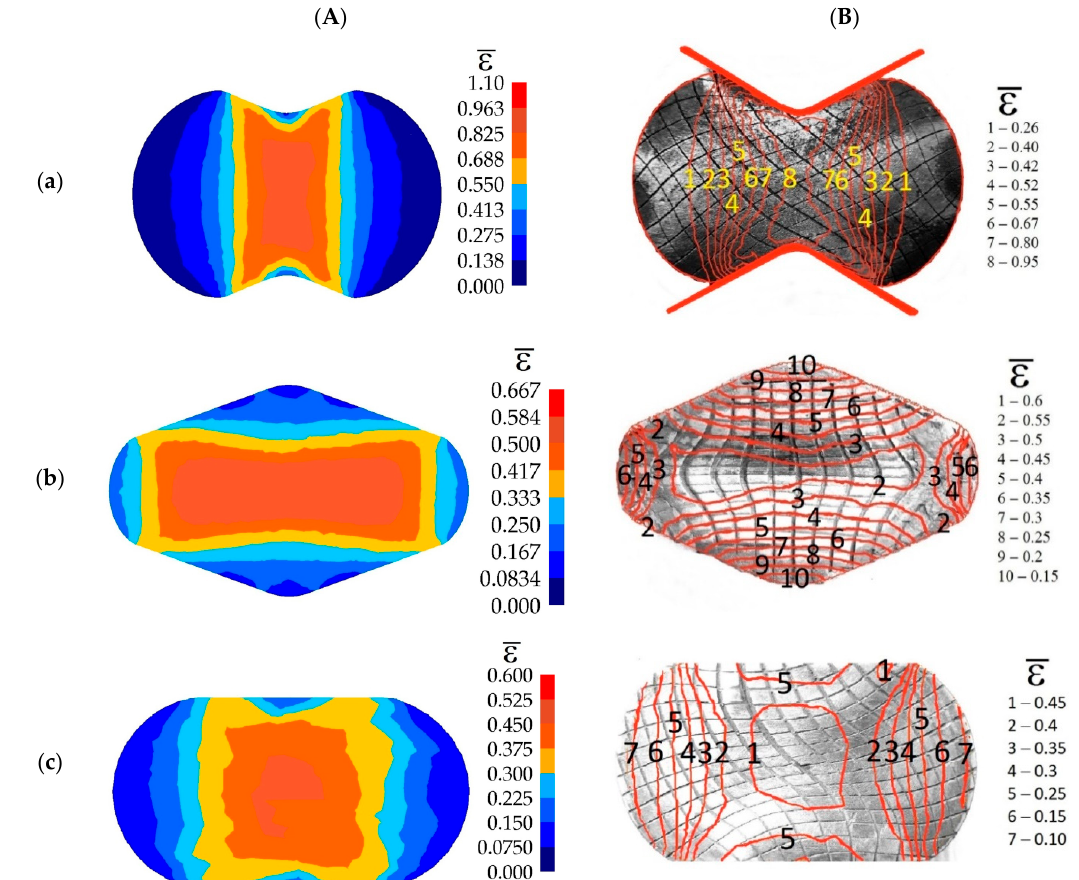
Figure 24. Comparisons of the numerical ( A ) and experimental ( B ) distribution of effective strain on the cross-section surfaces of the X5CrNi18-10 steel specimens deformed in anvils: ( a ) convex ( α c = 135°, ε c = 0.693), ( b ) V-shaped ( α = 140° × 140°, ε h = 0.35), and ( c ) flat ( ε h = 0.35).